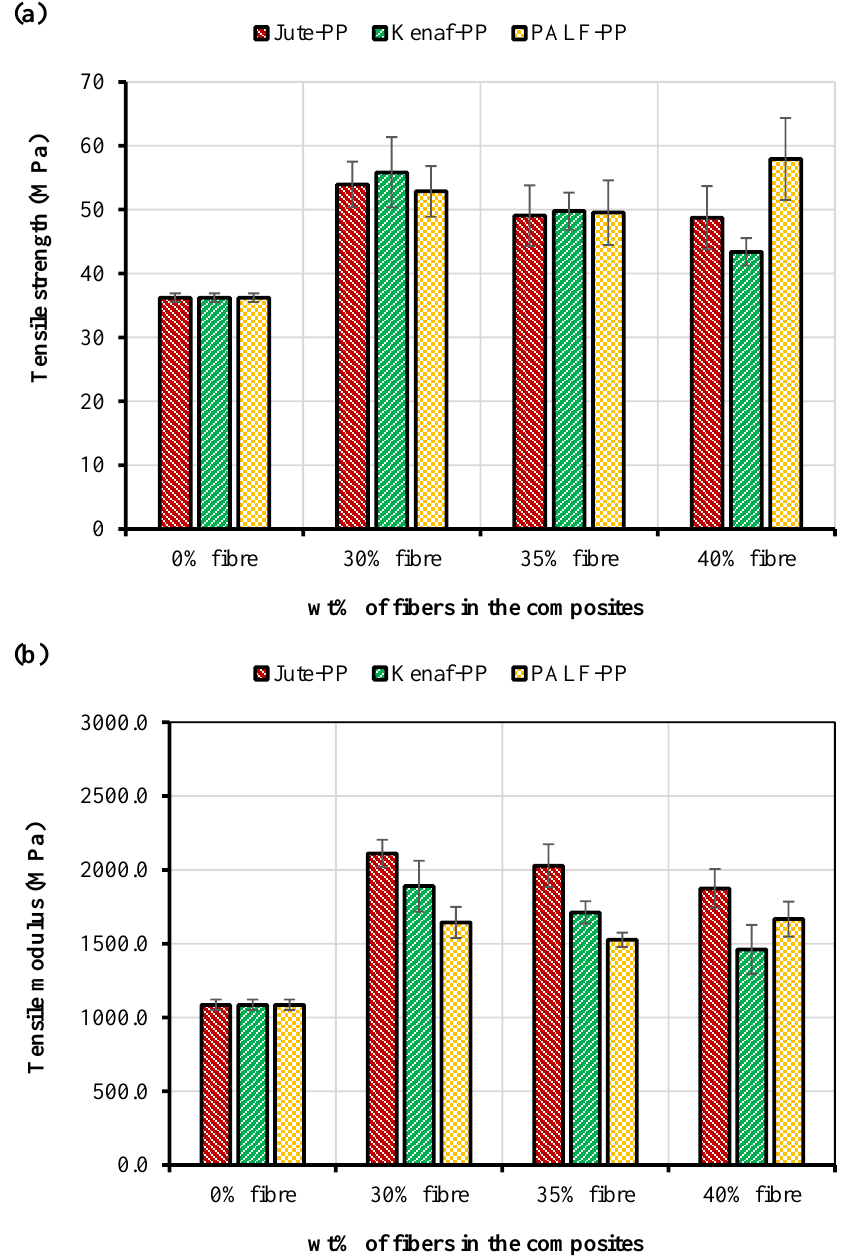
Figure 6. ( a ) Tensile strengths, ( b ) tensile moduli of the composite specimens. At low fiber content, a small fiber population contributes to low load transfer capacity among the fibers. As a result, accumulation of stress occurs at certain points of the compos- ite. It was evident that higher fiber loading increased the probability of fiber agglomeration within the matrix which produces non-uniform stress transfer and stress concentration promoting crack propagation. Moreover, too many fiber ends encourage micro crack forma- tion in the interface. As a result, the strength and modulus of the composite again decrease. Generally, the toughness of fiber-reinforced polymer composites is dependent on the fiber, the polymer matrix, and the interfacial bond strength